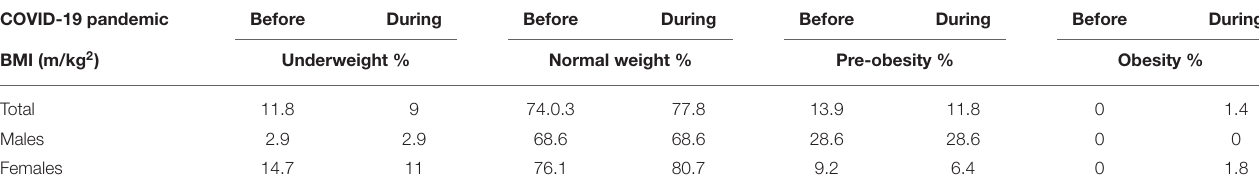
TABLE 2 | Nutritional status (BMI), χ 2 test by gender before COVID-19 (Pearson chi-square value = 10.518, df = 2, p = 0.005) and during COVID-19 pandemic (Pearson chi-square value = 14.106, df = 3, p = 0.003). COVID-19 pandemic Before During Before During Before During Before During BMI (m/kg 2 ) Underweight % Normal weight % Pre-obesity % Obesity % Total 11.8 9 74.0.3 77.8 Males Females 14.7